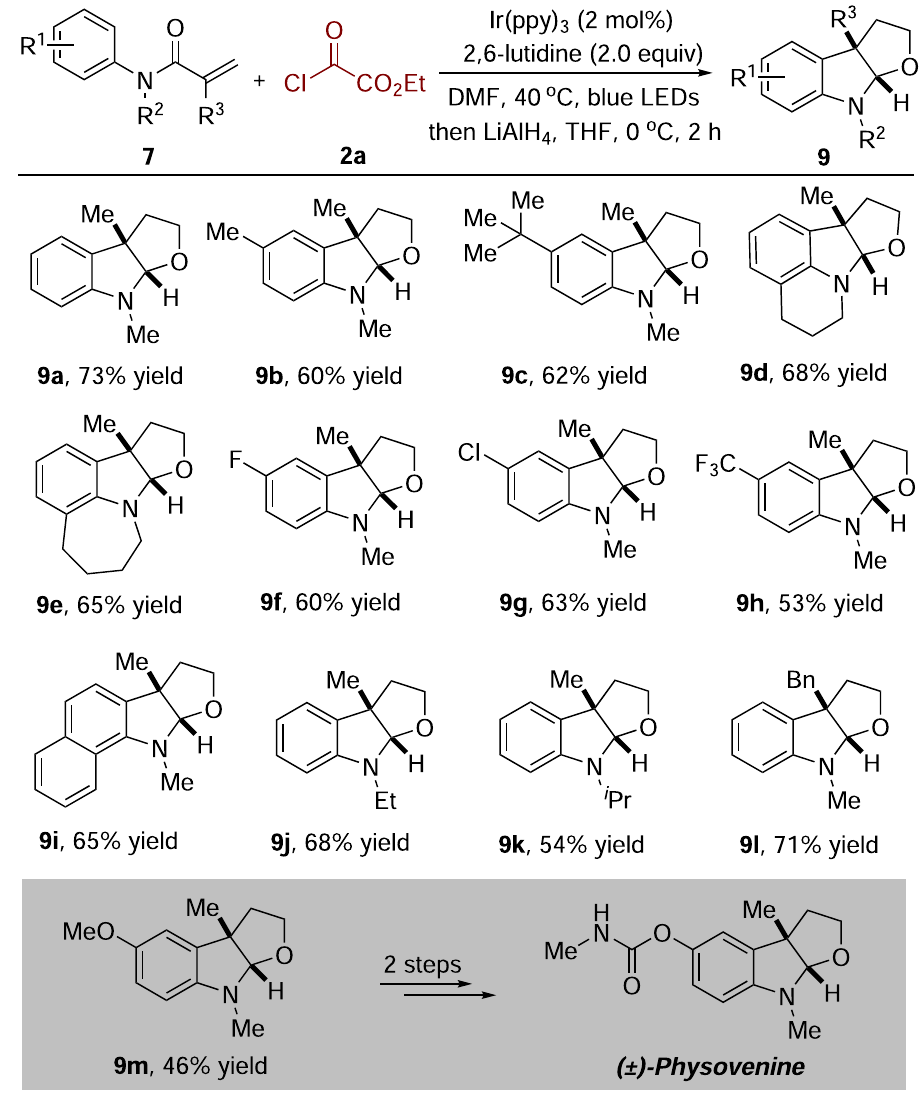
Fig. 6 Synthesis of furoindoline derivatives. Isolated yields based on N -arylacrylamide 7